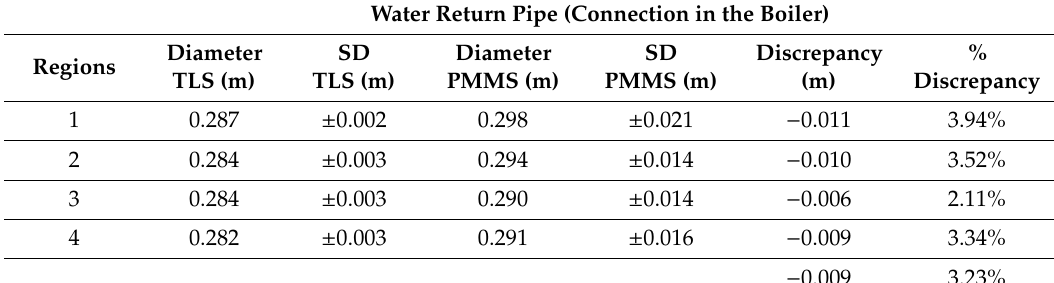
Table 4. Diameters discrepancies and standard deviations (SD) obtained from the RANSAC cylinder fitting of the pipes: water return pipe regions located in the boiler (Figure 7).